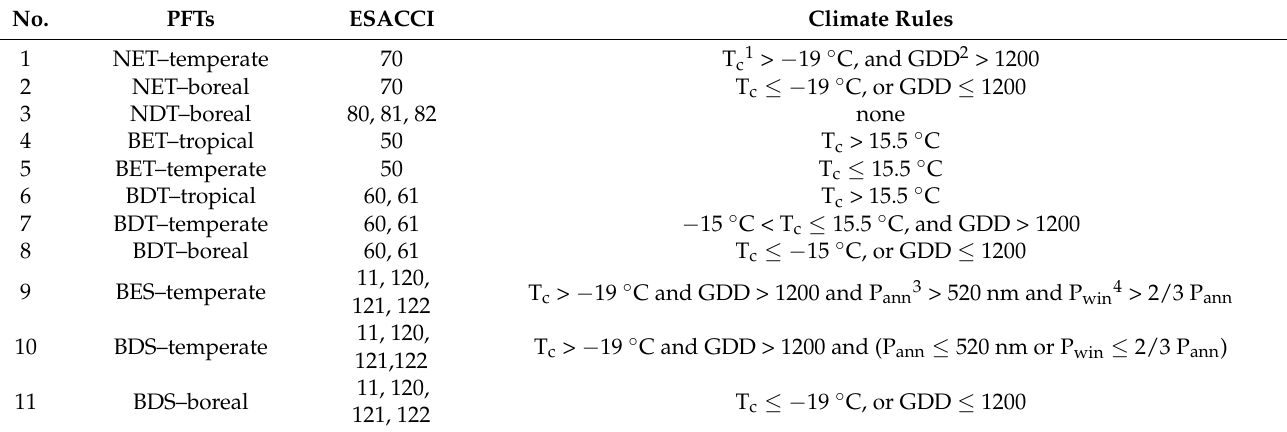
Table 2. Classification basis and classification